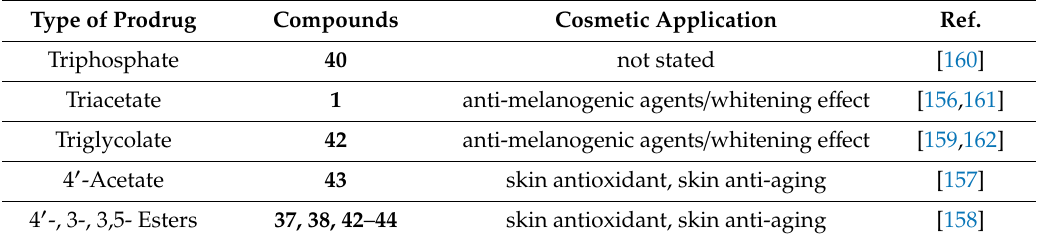
Table 7. Summary of RSV prodrugs for dermal delivery and their cosmetic